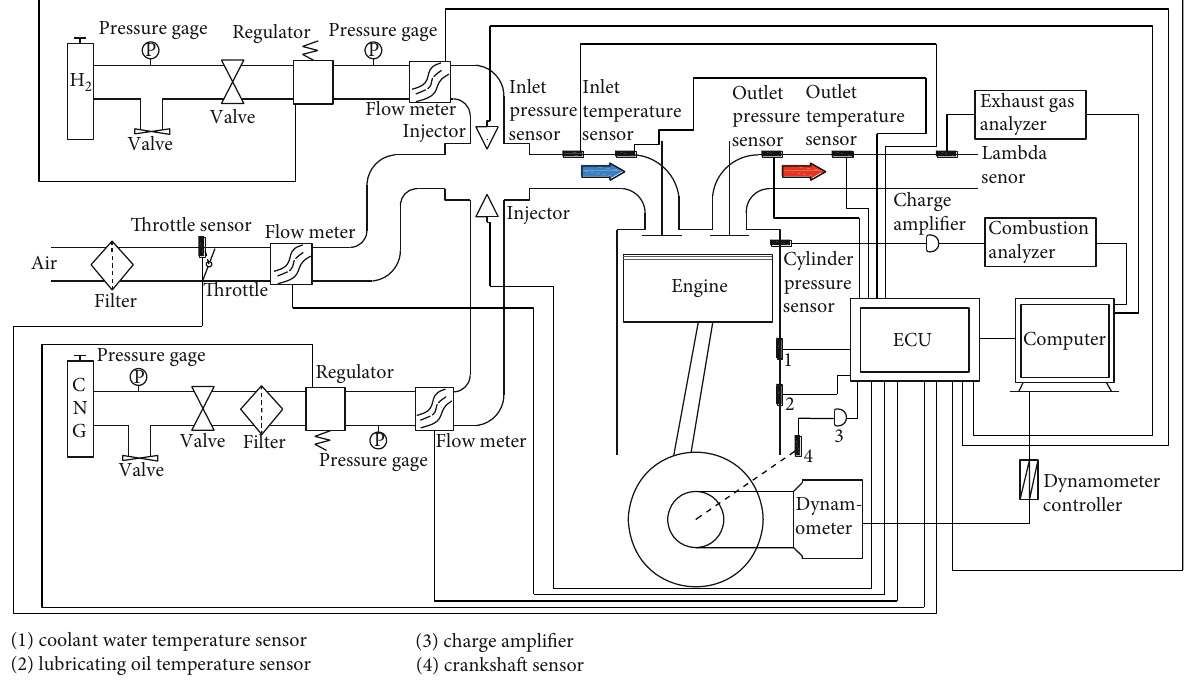
Figure 1: The schematic diagram of the test bench.